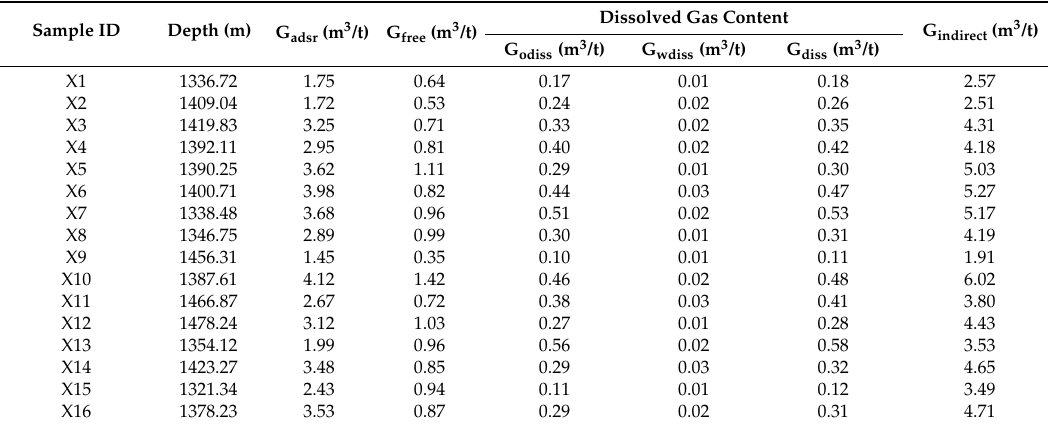
Table 3. The results of shale gas content by the indirect